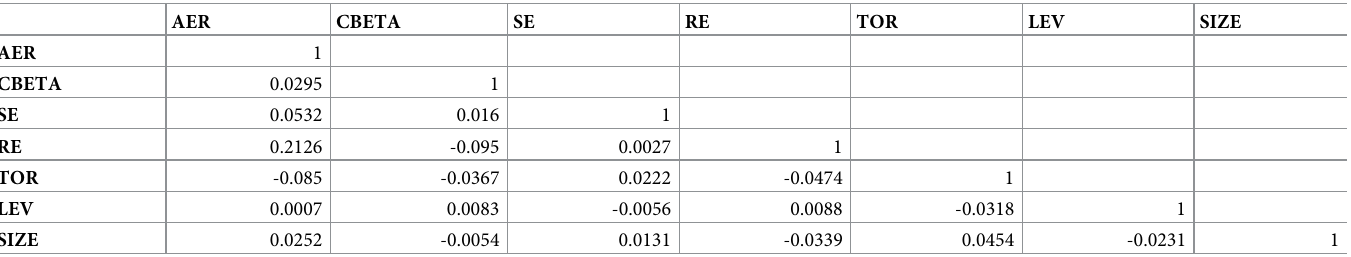
Table 1. Correlation matrix